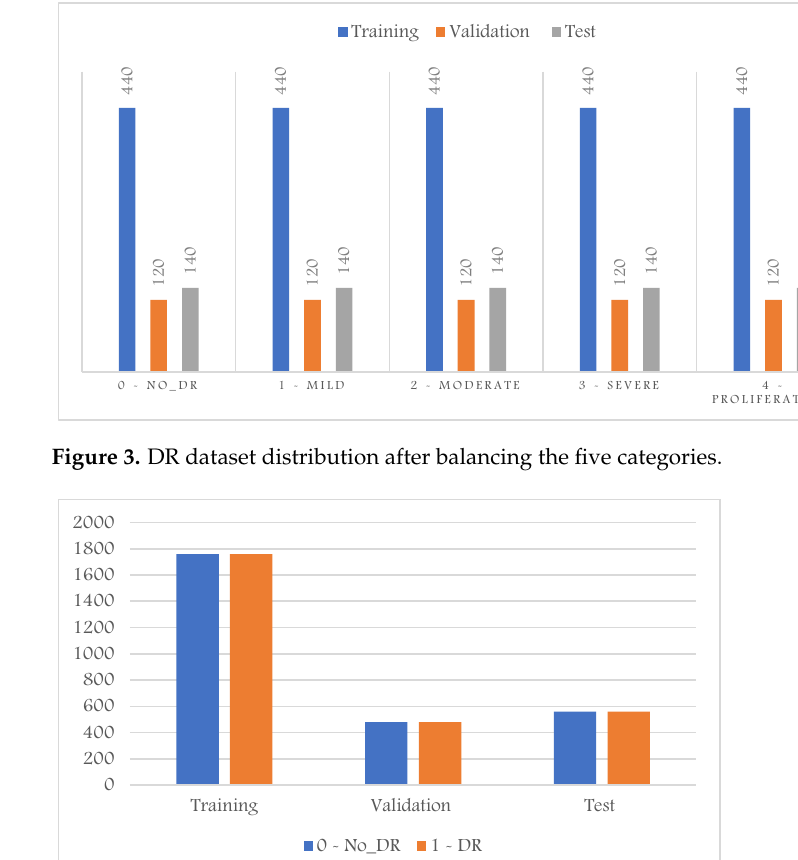
Figure 2. Original DR dataset distribution.